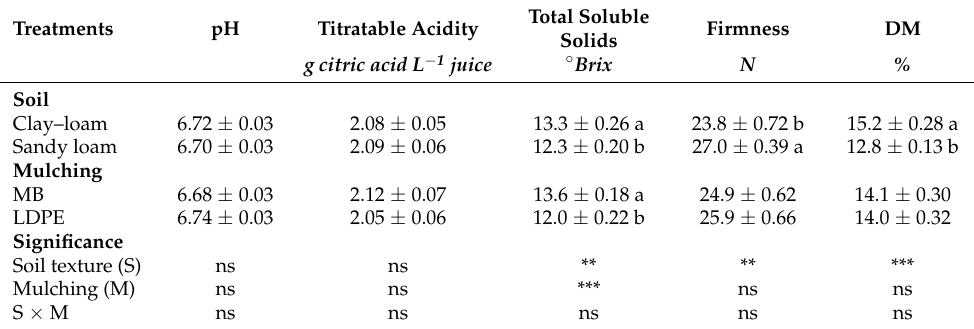
Table 3. Effect of soil texture (clay–loam—CL; sandy loam—SL) and mulching (biodegradable film— MB; low density polyethylene—LDPE) on pH, titratable acidity, total soluble solids, firmness, and dry matter percentage of muskmelon